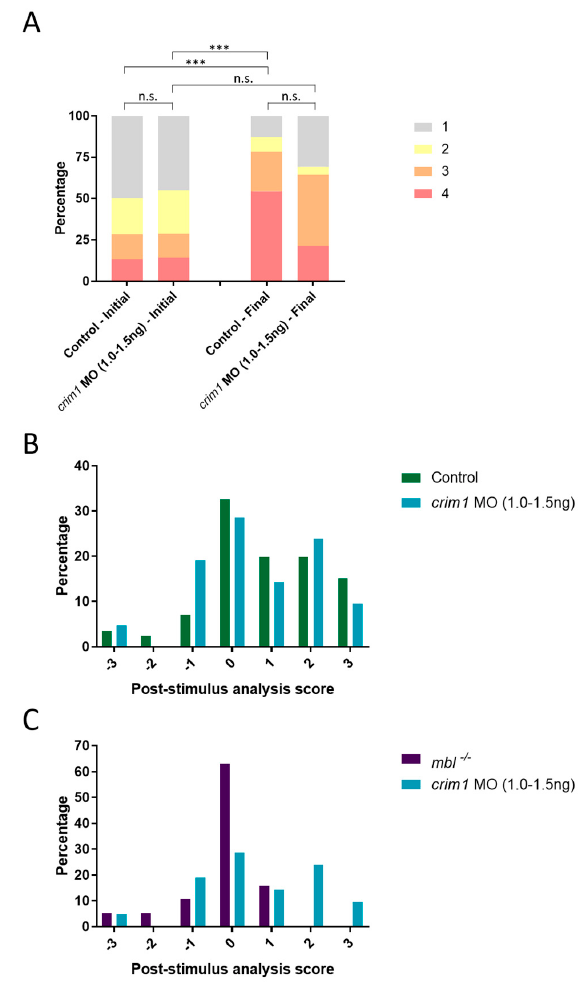
Figure 6. crim1 morphants respond to OMR. ( A ) OMR analysis of control ( n = 39) and crim1 AUG MO at 1.0–1.5 ng ( n = 31) larvae plotted as a bar graph which shows the shifts in the population between the initial and final positions (Bowker’s test of symmetry, p -value *** = 0.0004); ( B ) Individual analysis compared to wild type; ( C ) individual analysis compared to mbl − / − . Control and crim1 morphant larvae respond to the OMR. n.s., not significant.